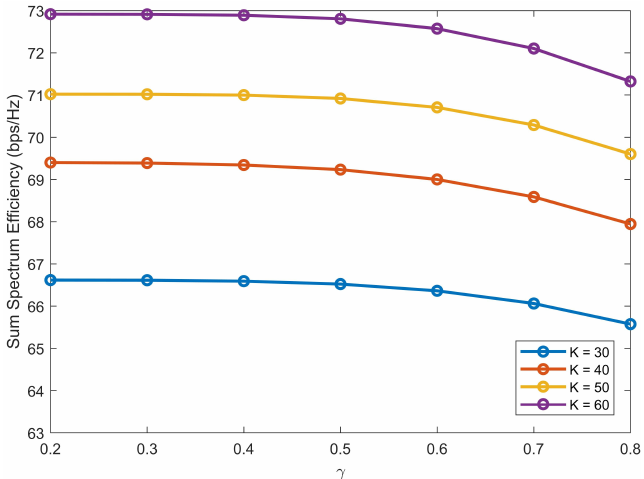
Figure 3. SE versus γ .